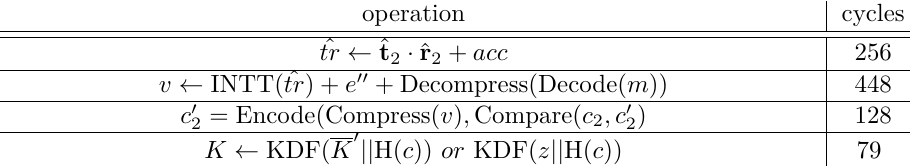
Table 8: Detailed procedures in server side and corresponding cycle counts in implementing Kyber.CCAKEM protocol when k =3 (continued).